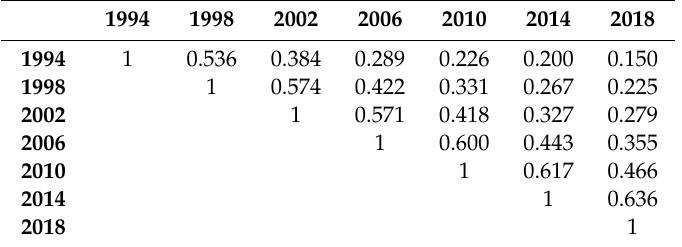
Table 4. Inter-electoral stability (uniformity) of the spatial patterns of women’s descriptive representation in Czech local elections, 1994–2018 (Pearson correlation coe ffi